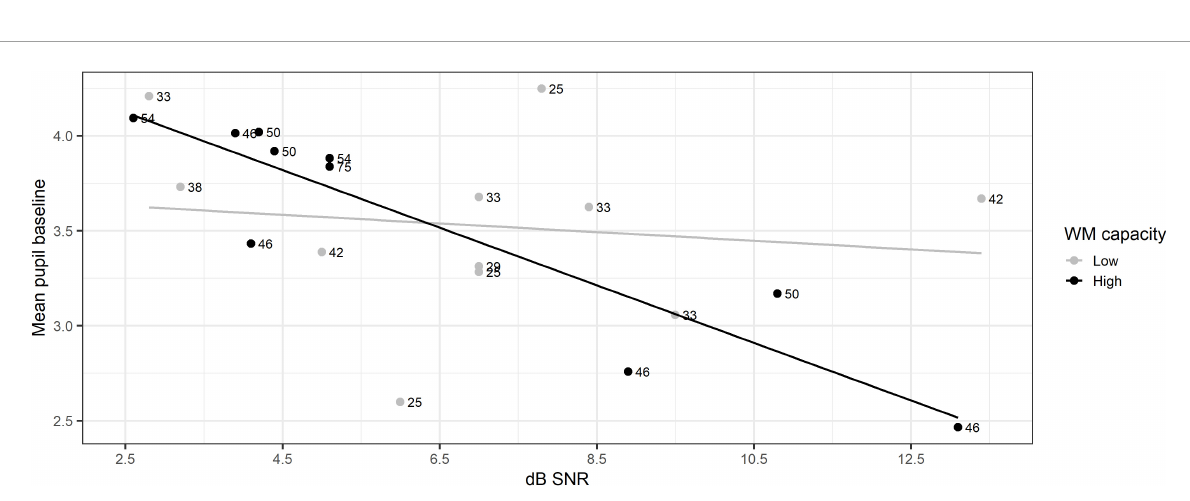
FIGURE5 Mean pupil baseline as a function of Reading Span test score and signal-to noise ratio (SNR). The dots show the individual Reading Span test scores for the low working memory (WM) capacity group (light gray) and high WM capacity group (black). The regression lines were fitted for each